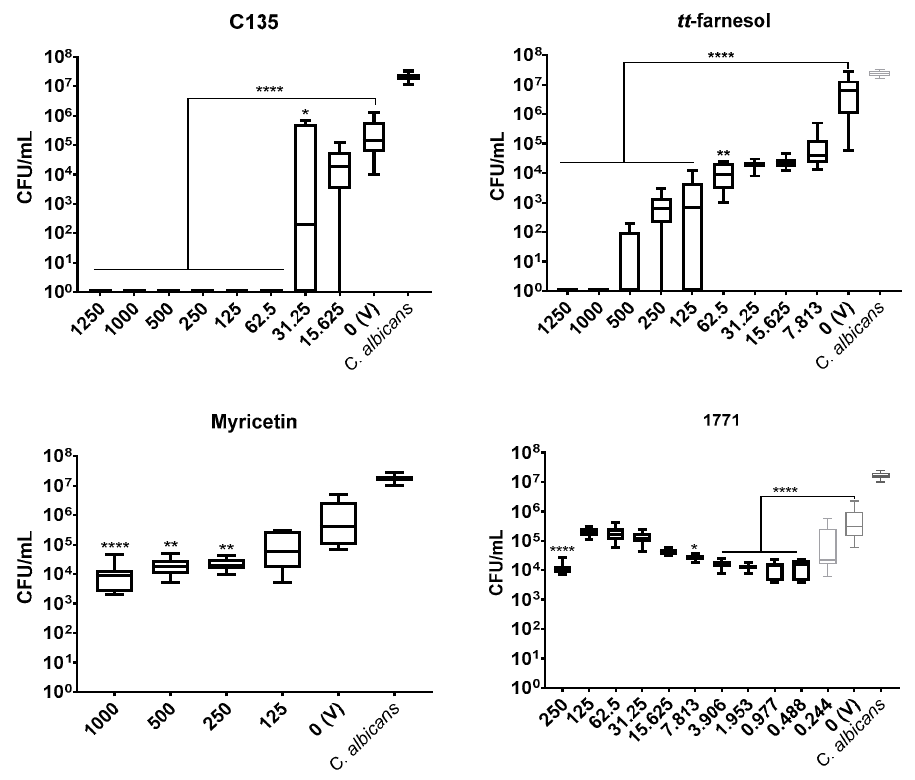
Figure 2. Antimicrobial activity of C. albicans with compounds: C135, tt -farnesol, myricetin and 1771. Data represents median and interquartile ranges ( n = 9). Statistical differences are represented with * (C135 p = 0.048; 1771 p = 0.013), ** ( p < 0.05) and **** ( p < 0.0001) (Kruskal Wallis, followed by Dunn’s test). The tabulated results are in Table S2.